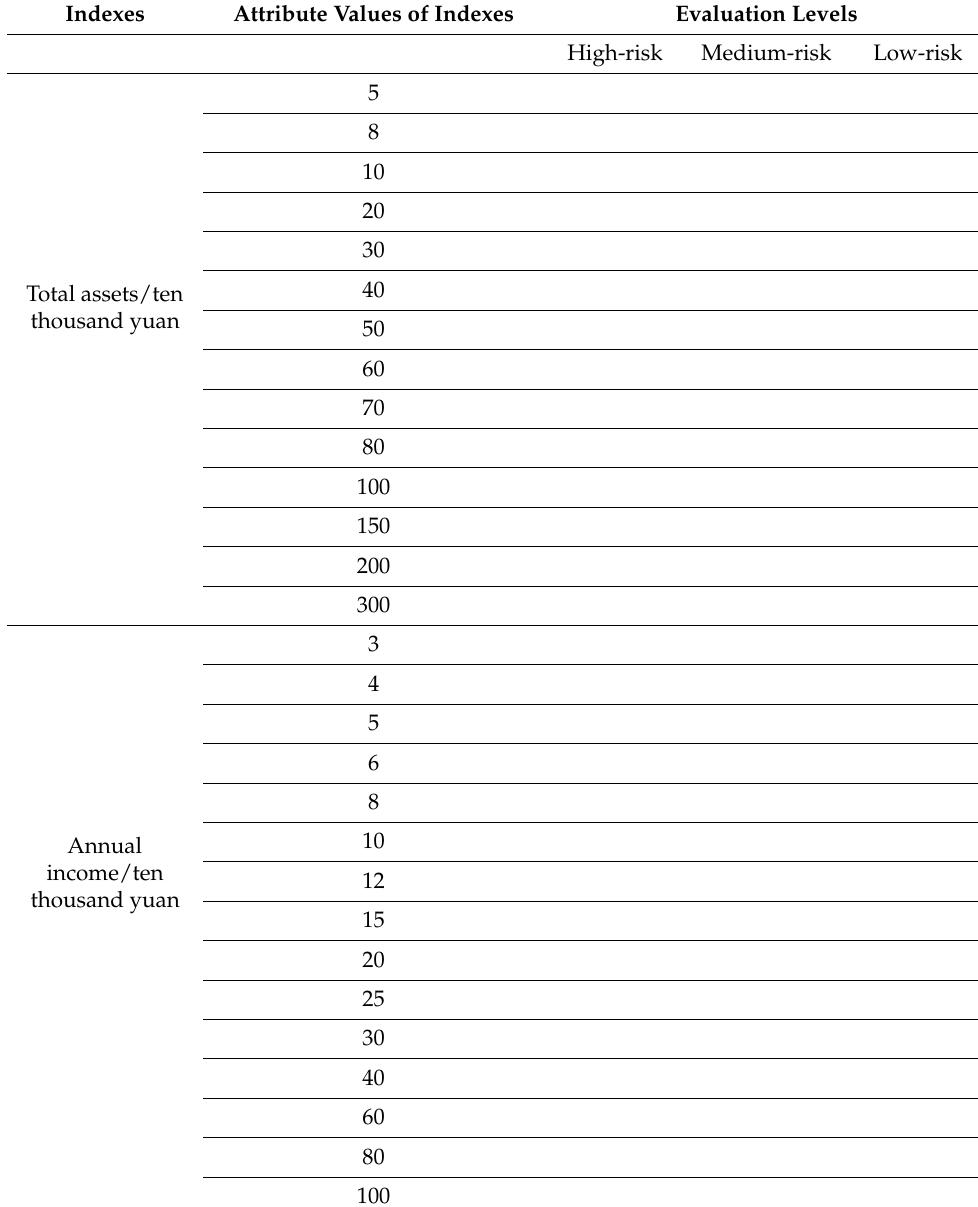
Table A9. Single factor evaluation of economic situation